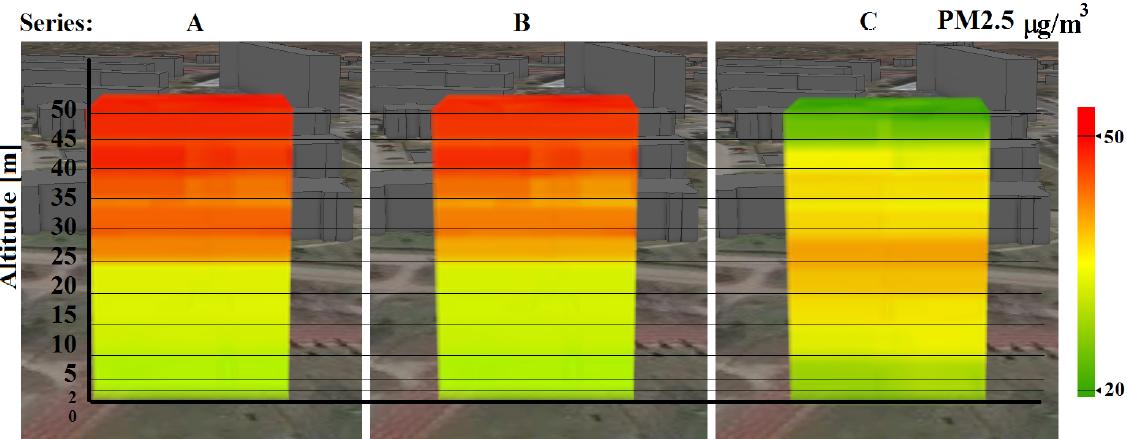
Figure 6. Spatial distribution of PM 2.5 pollution with altitude for three measurement series in the VEIP station area.